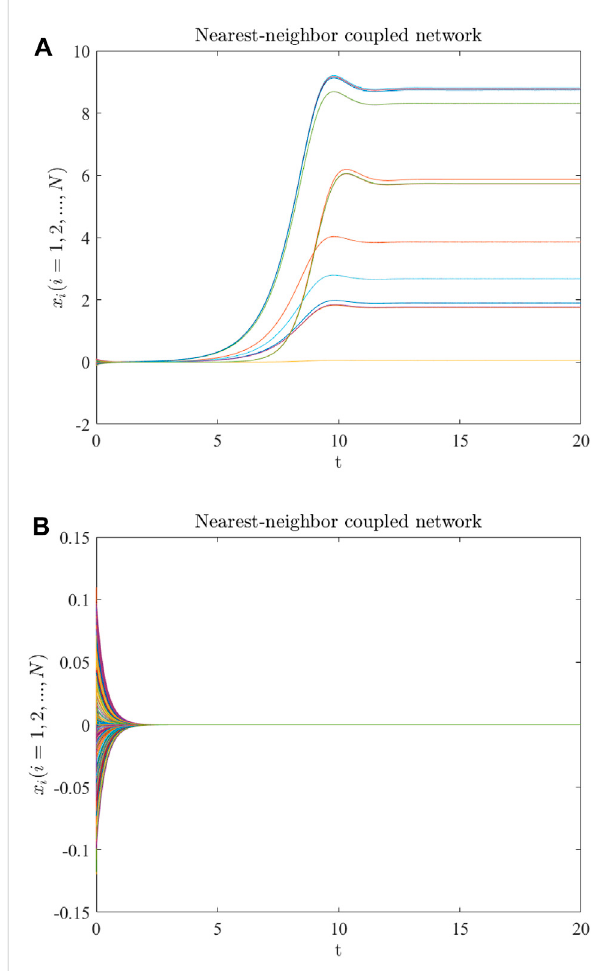
FIGURE 5 Evolution of the node states in a 17-node globally coupled network of Lü systems with (A) σ = 5; (B) σ = 6.